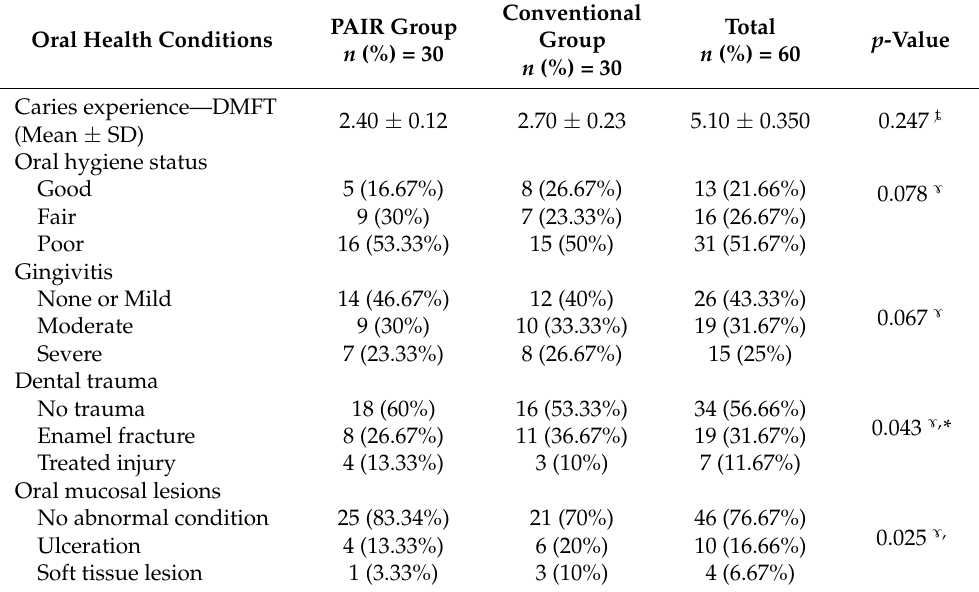
Table 2. Frequency of oral health conditions and their